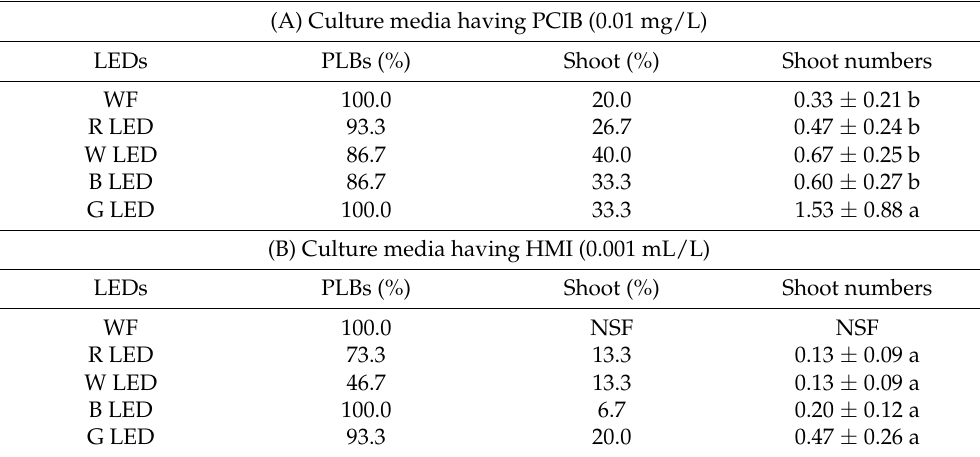
Figure 5. The number of newly generated PLBs of D. okinawense under different LEDs using PCIB- and HMI- manipulated culture media. Blue, green, and red bars represent non-manipulated culture media (C), 0.01 mg/L PCIB-manipulated culture media (PCIB), and 0.01 mL/L HMI-manipulated culture media (HMI), respectively (total number of explants, n = 15). Values are means ± standard error (s.e.; n = 15). Upward arrows represent the percentage of increase from the respective horizontal lines and downward arrow represents the percentage of decrease. Black, green, and dark red dotted horizontal lines represent the mean number of PLBs, respectively, produced by control under white fluorescent light, control under red LED, and control under green LED. The color of the different upward arrows represents the increase from the mean (similar colored dotted horizontal line) level. Letters above the bars that share the same letter are statistically identical and those that do not share the same letter are statistically different at p ≤ 0.05 using Tukey’s multiple comparison test (significance levels between the same color letters only). Here, ***; p ≤ 0.01, ns; not significant by student t -test. Table 2. PLBs proliferation percentage (%), shoot formation percentage (%), and number of shoots regenerated under different